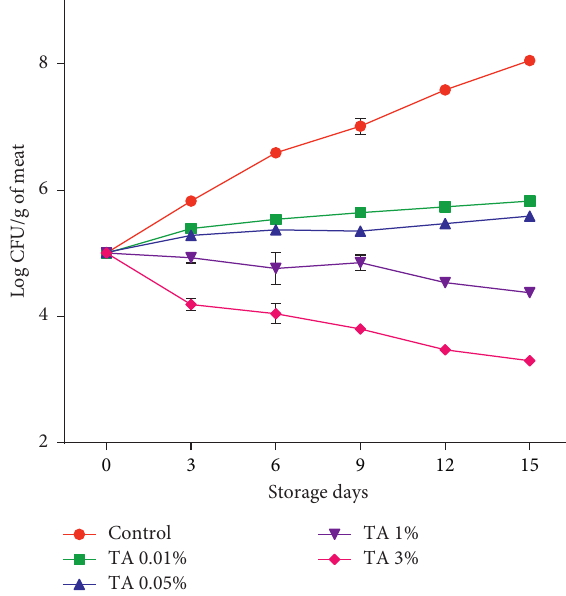
Figure 4: Time-related survival, at 4 ° C, of the low meat con- tamination level (10 5 CFU/g) of P. aeruginosa , following treatment with increasing concentrations of T. algeriensis EO. The results represent the means of three replicate experiments, and error bars represent the standard error of the mean. Statistical significance differences: ∗ p < 0 . 05 (significant), ∗∗ p < 0 . 01 (very significant), and ∗∗∗ p < 0 . 001 and ∗∗∗∗ p < 0 . 0001 (extremely significant). CFU: colony-forming unit; TC: Thymus algeriensis .